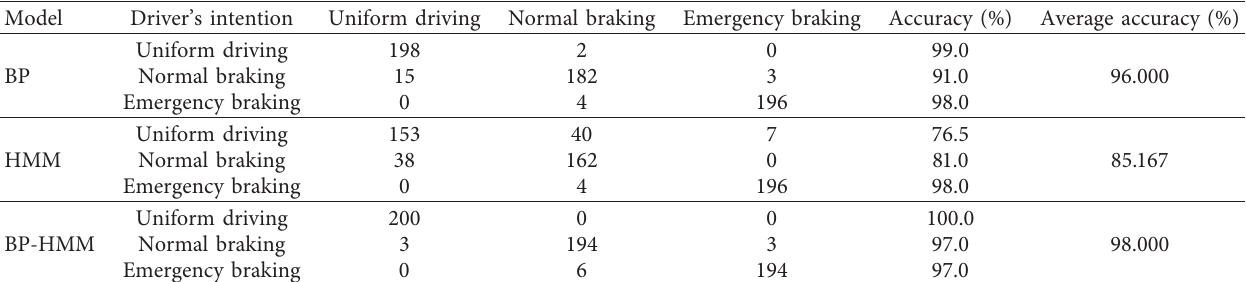
Table 3: Comparison of recognition accuracy of different driver’s intention recognition